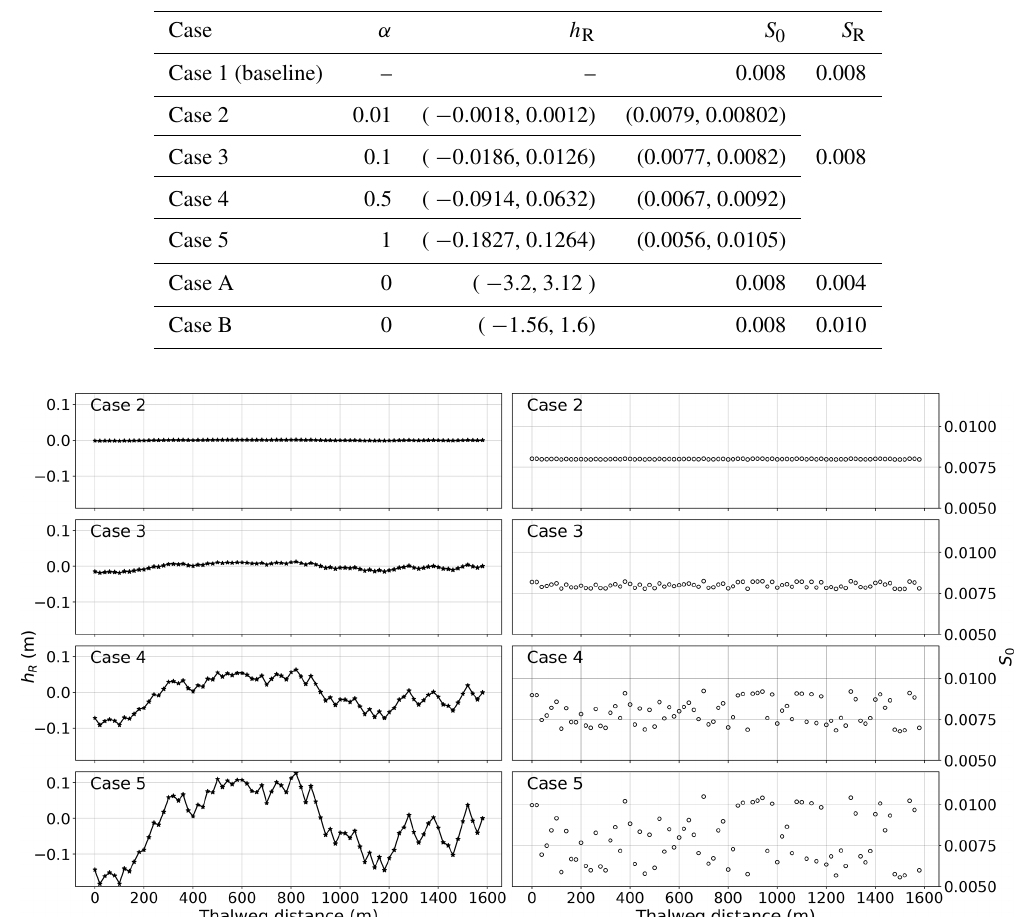
Table 2. Configuration of synthetic channel reach test cases: α is used in Eq. (20) for random perturbation of the baseline Case 1 geometry; h R is the bed offset based on Fig. 4 with parentheses indicating upper and lower limits of randomized geometry values over the nonuniform test reach; S 0 is the range of the thalweg slope for z 0 from Eq. (20); and S R is the selected uniform reference slope.